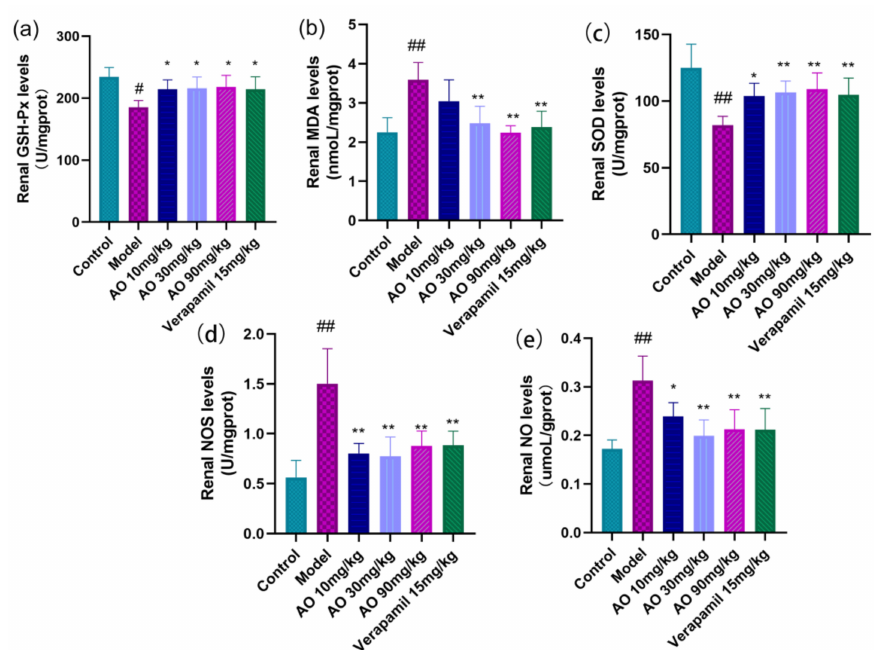
Figure 4. Regulation of AO on markers of oxidative tissue damage in kidney tissue of AKI rats. ( a ) Glutathione peroxidase (GSH-Ps), ( b ) malondialdehyde (MDA), ( c ) superoxide dismutase (SOD), ( d ) nitric oxide synthase (NOS), ( e ) nitric oxide (NO); # p < 0.05 vs. control group, ## p < 0.01 vs. control group. * p < 0.05,** p < 0.01 vs. model group ( n =